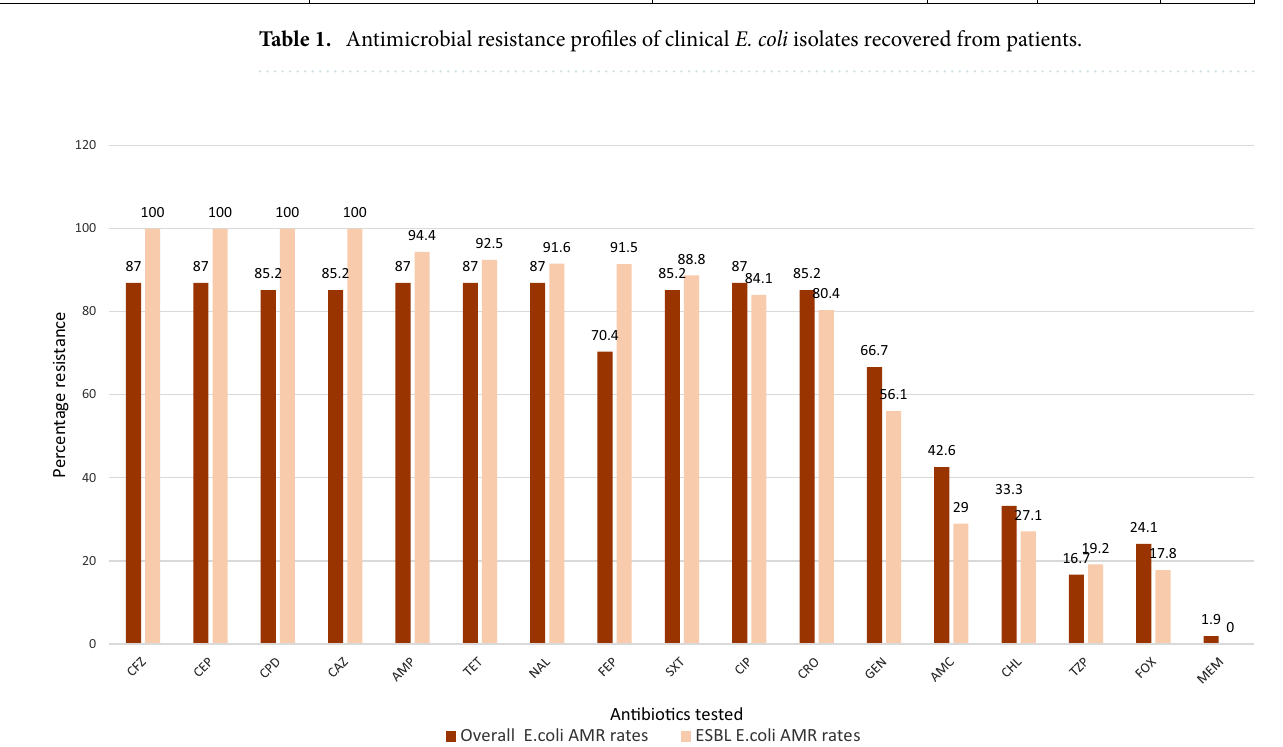
Figure 2. Comparison of antimicrobial resistance profiles of all isolates vs ESBL E. coli isolates expressed in